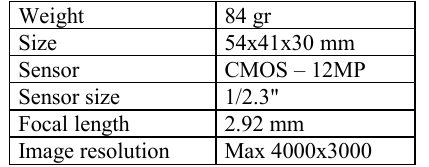
Table 1. GoPro Hero 4 Silver main specifications.